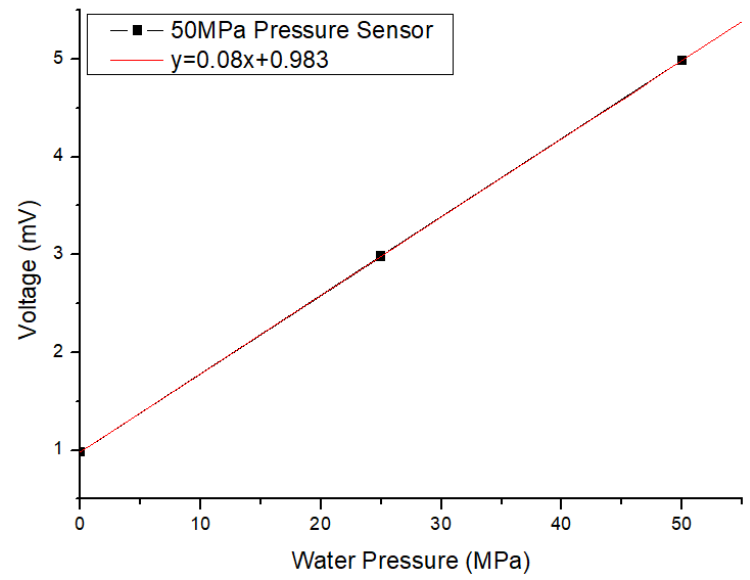
Figure 5. Explosive pressure bar calibration results.